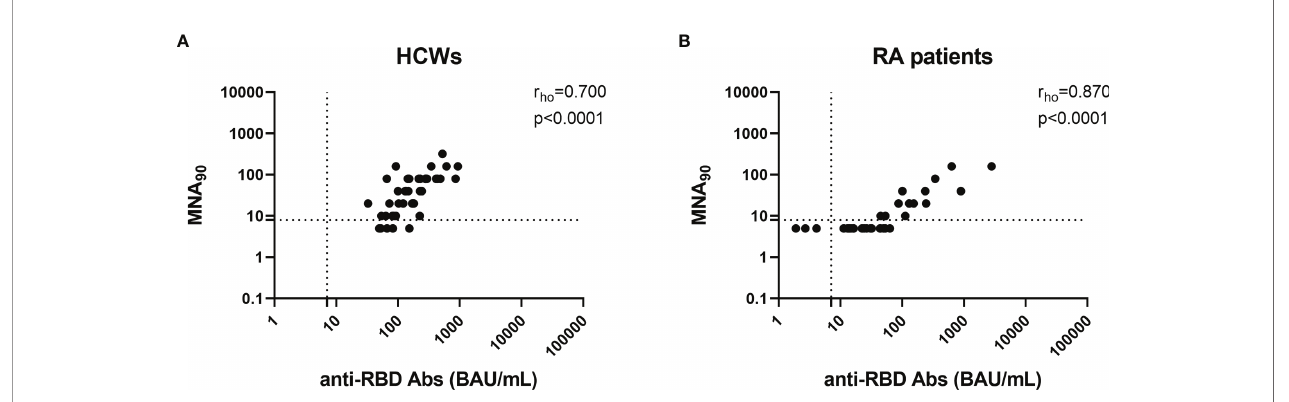
FIGURE 3 | Anti-RBD and neutralizing antibodies correlate with each other in both HCWs and RA patients. Correlation between anti-RBD-IgG titers and neutralizing antibodies in 42 HCWs (A) and 35 RA patients (B) . Anti-RBD and neutralizing antibodies were quanti fi ed in serum samples and expressed as binding antibody units (BAU)/ml and reciprocal of dilution (MNA 90 ), respectively. Dashed lines identify the cutoff of each test (anti-RBD: 7.1 BAU/ml and MNA 90 : 8). Statistical analyses were performed using Mann – Whitney U-test with Bonferroni correction (p ≤ 0.0125). Correlation between assays was assessed by non-parametric Spearman ’ s rank test, and p < 0.05 was considered signi fi cant. CCS, corticosteroid; DMARDs, disease-modifying antirheumatic drugs; RA, rheumatoid arthritis; RBD, receptor-binding domain; HCWs, health care